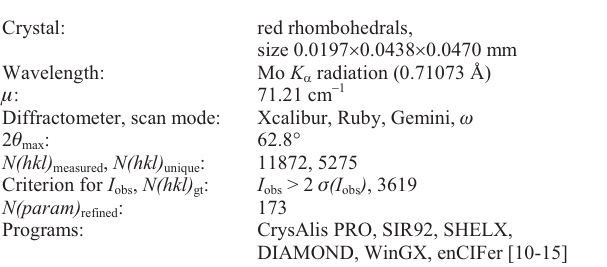
Table 1. Data collection and